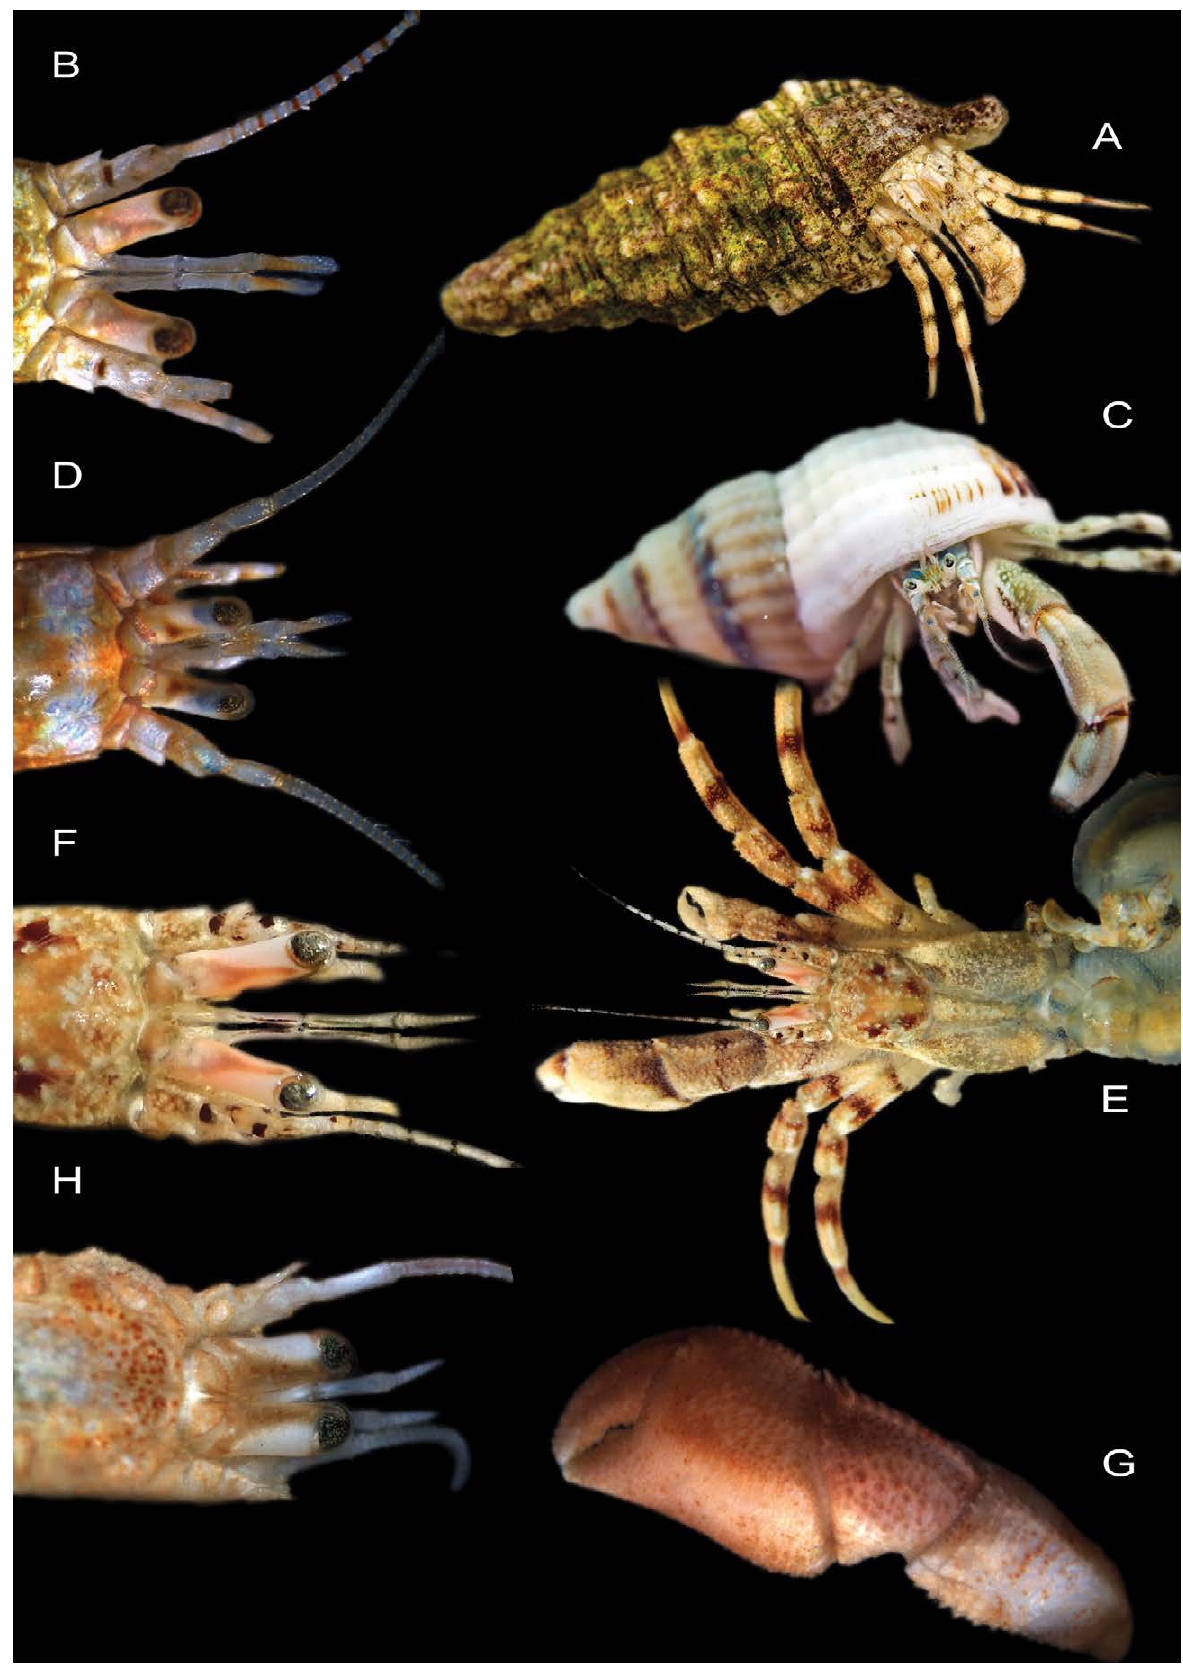
Fig. 17. – Colour photographs of the species of the genus Diogenes . A, B, Diogenes armatus (MNHN-IU-2019); C, D, Diogenes curvimanus (ZSMA2019 398); E, F, Diogenes pugilator (IEOCD-BR/2669); G, H, Diogenes erythromanus